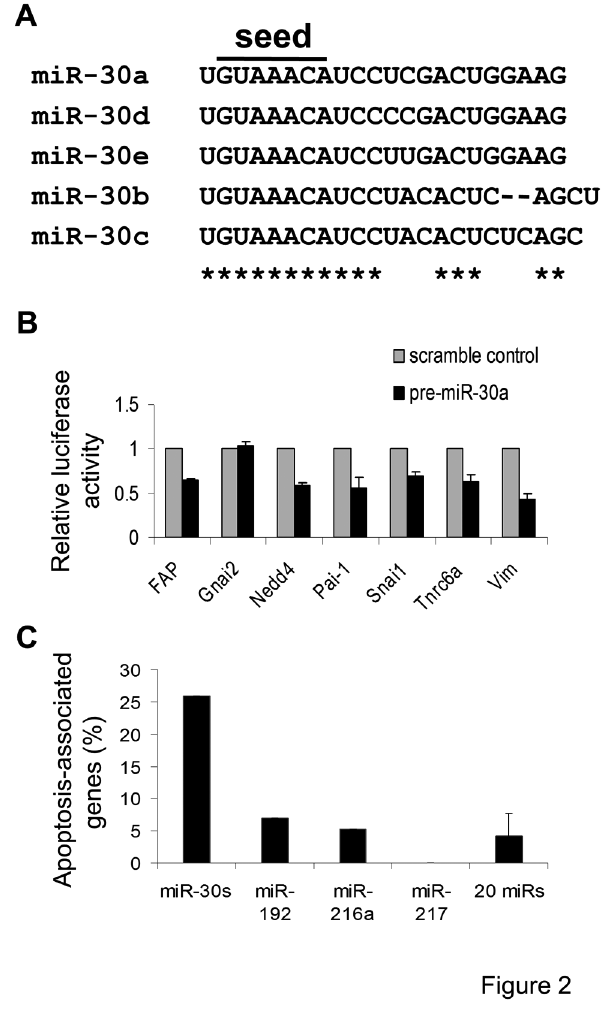
Figure 2. Genes associated with apoptosis are significantly enriched among the predicted target genes of miR-30s. A . Alignment of the sequences of mature miR-30 family members with seed sequence motifs (indicated by a line). B . Bar graph showing the mean ± S.D. of the activity of luciferase reporter constructs carrying 3’ UTR sequence fragments of seven genes randomly chosen from the 155 predicted miR-30 target genes. Reporter constructs were cotransfected with either a scrambled miR expression construct (control) or a synthetic miR-30 precursor (pre-miR-30a). The results were normalized by the activity of renilla luciferase, the expression construct of which was co-transfected. C . Bar graph shows the fraction of genes annotated with the biological process, ‘apoptosis’ (Ingenuity Systems), among all the predicted target genes of TGF-β-regulated miR-30s, miR-192, miR-216a, and miR-217 or the mean ± S.D. of 20 randomly chosen miRs that are not known to be regulated by TGF-β